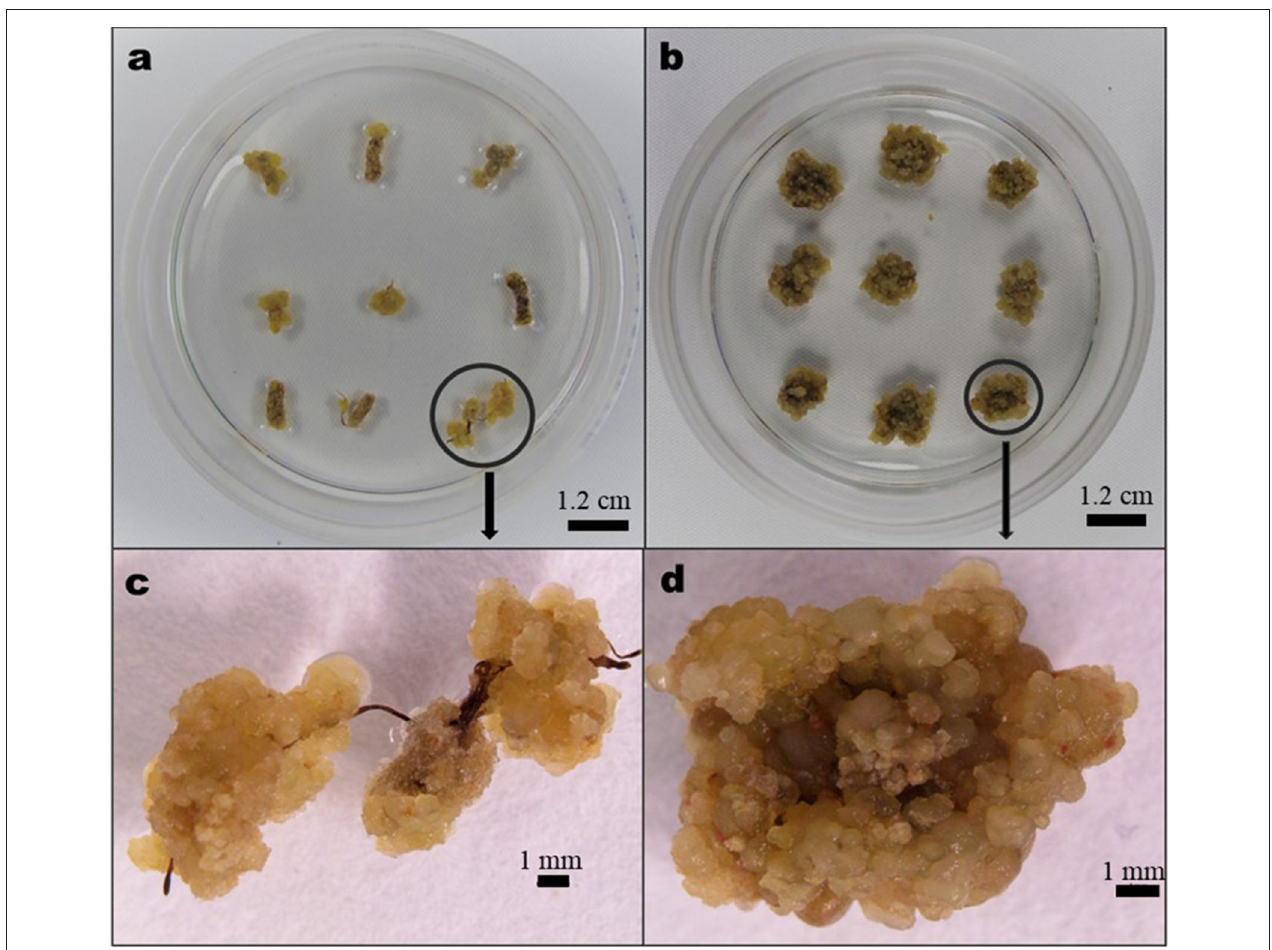
FIGURE 1 | Characteristic nature of Aspilia africana callus: (a) calli from root explant generated in 0.5 mg/L benzylaminopurine (BAP) in combination with 1.0 mg/L 2,4-dichlorophenoxyacetic acid (2,4-D), (b) calli from leaf explant generated in 1.0 mg/L BAP combined with 1.0 mg/L 2,4-D, (c) magnified callus (encircled) in (a) , and (d) magnified callus (encircled) in (b)